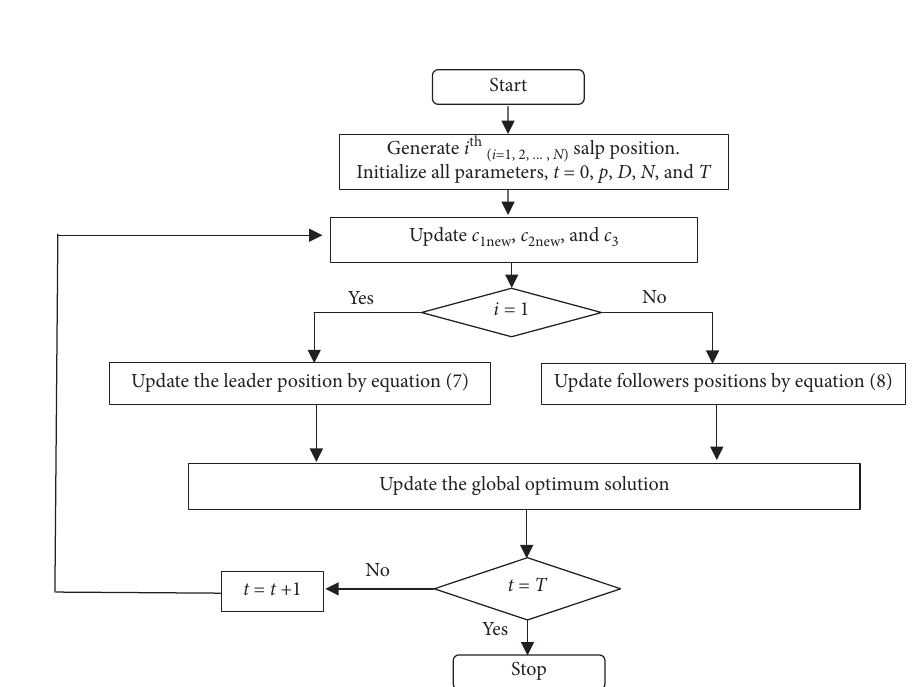
Figure 1: The flowchart for